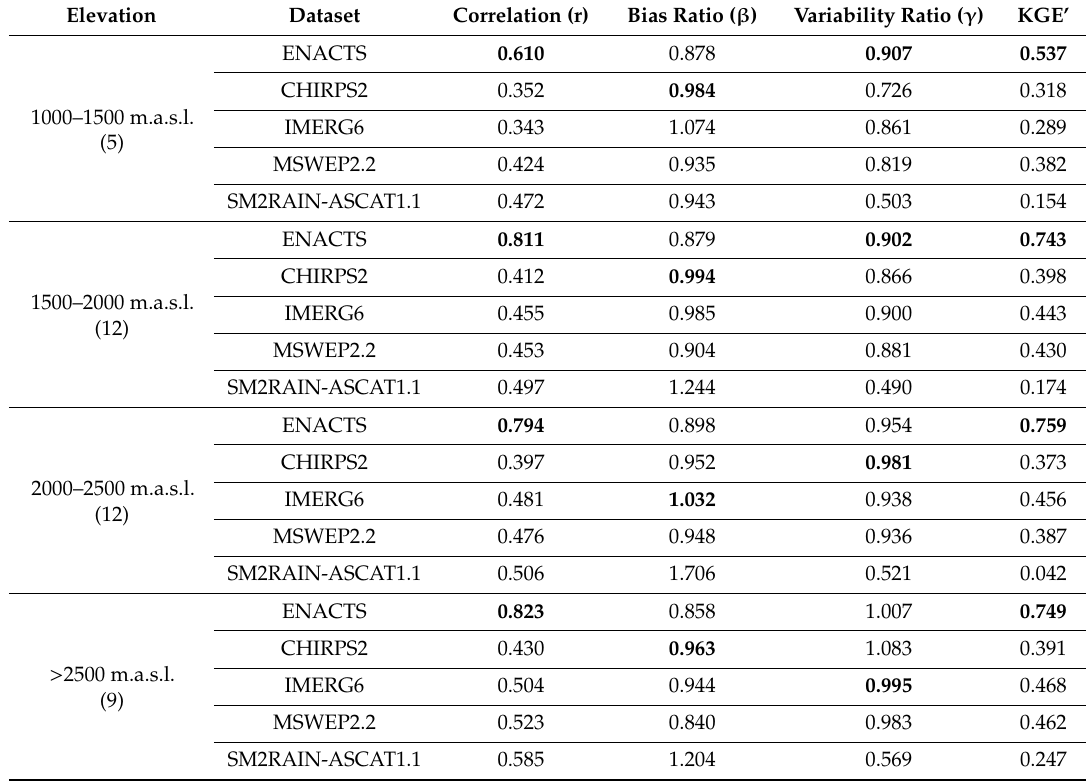
Table 2. Daily scale median values of modified Kling-Gupta e ffi ciency (KGE’) and its components grouped for di ff erent elevation ranges for UBNRB. The number in brackets indicates the number of stations in the elevation range. Values in bold show the best score of each dataset in each elevation